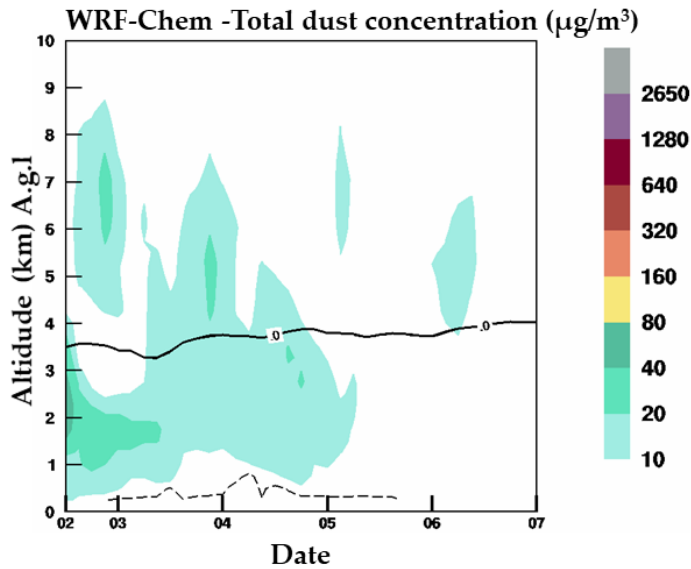
Figure 9. Modeled dust concentration (in µ g/m 3 ) on 2 June 2019 12:00 UTC–7 June 2019 00:00 UTC.